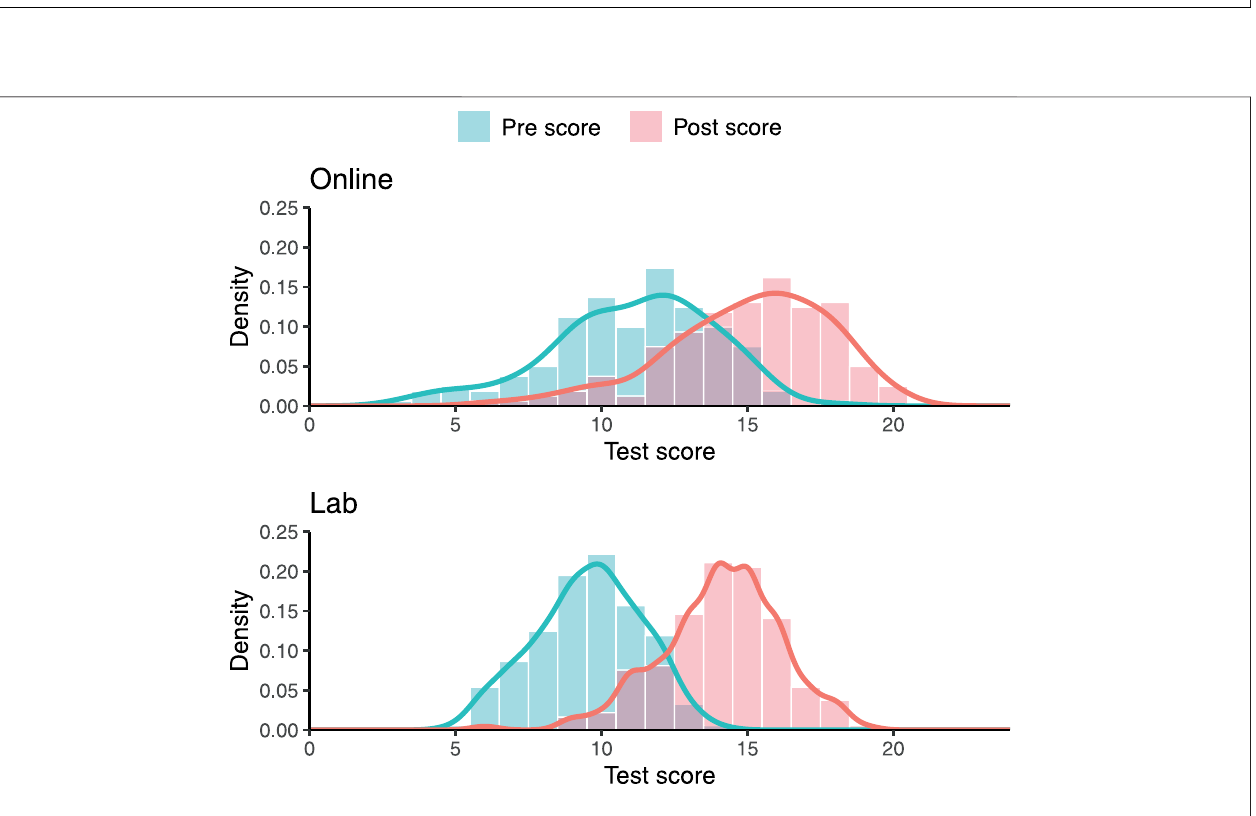
Frontiers in Virtual Reality |